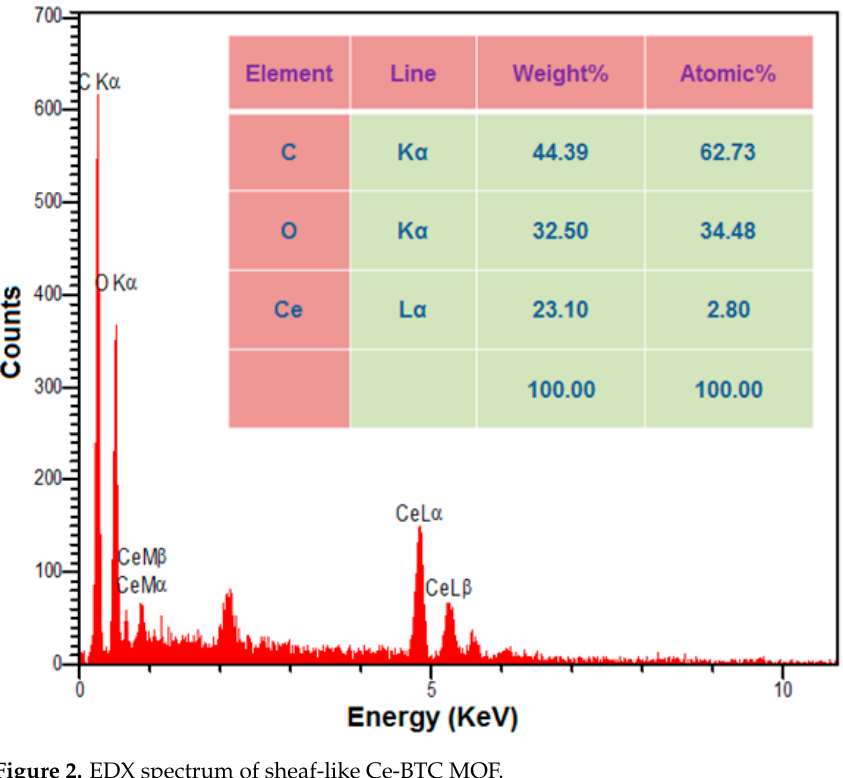
Figure 2. EDX spectrum of sheaf-like Ce-BTC MOF.